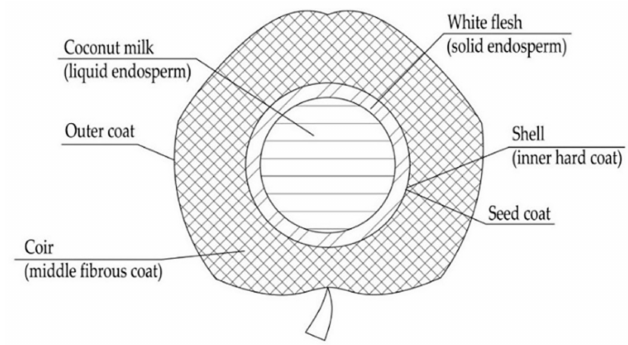
Figure 1. Schematic of the fruit of the coconut